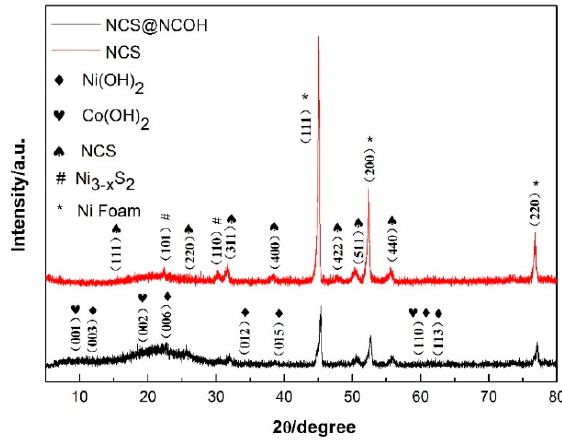
Figure 4. XRD patterns of the NCS nanotube arrays and NCS@NCOH core-shell nanotube arrays on Ni foam.